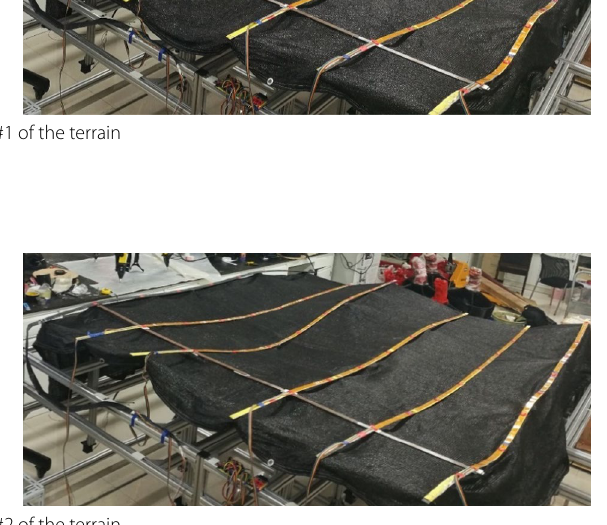
Fig. 13 Shape #2 of the terrain